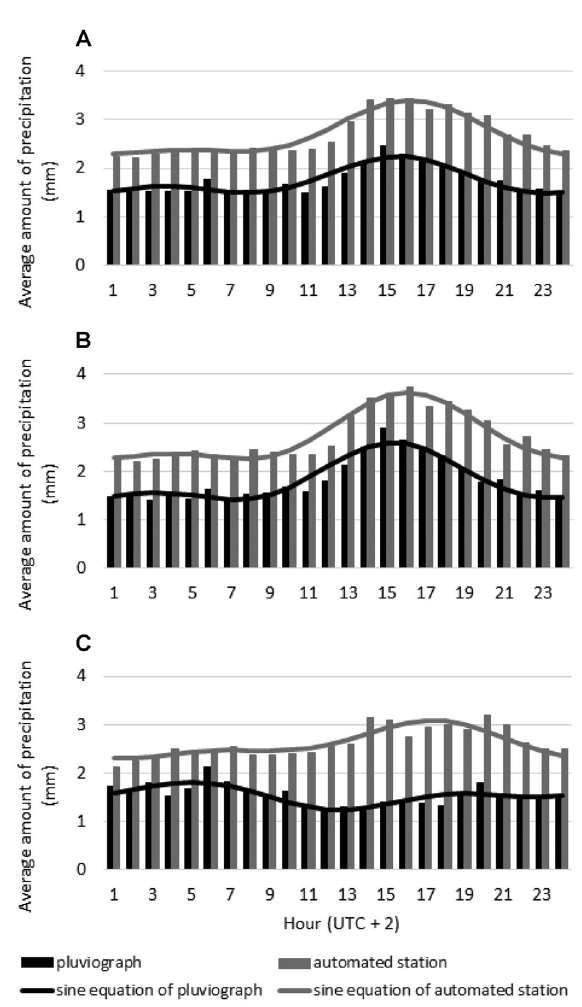
Fig. 2. Annual mean distribution of hourly precipitation amounts (mm) from May to October at all stations of Estonia ( A ), and separately at the continental ( B ) and coastal stations ( C ) according to the pluviographic data from 1991– 2003 (black columns) and automated weather station data from 2003–2013 (grey columns). Thick lines present the approximating diurnal curves of